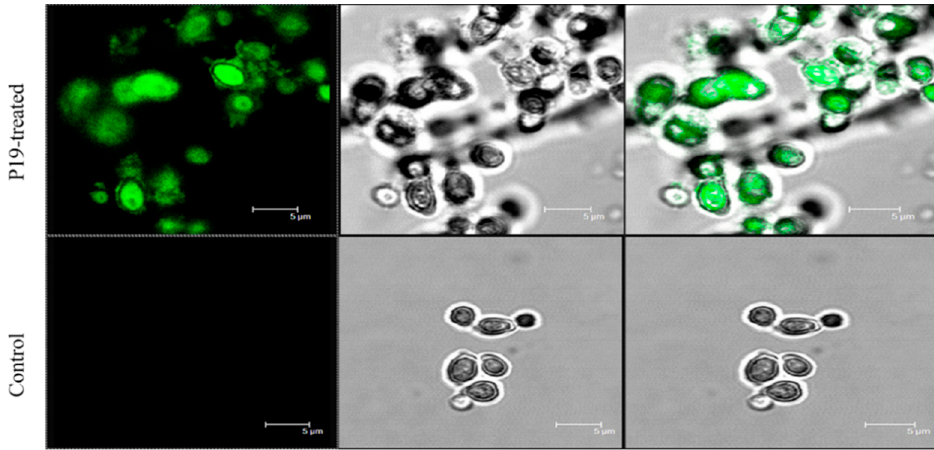
Figure 10. CLSM of C. albicans 2.2086 treated with potential peptide or none.